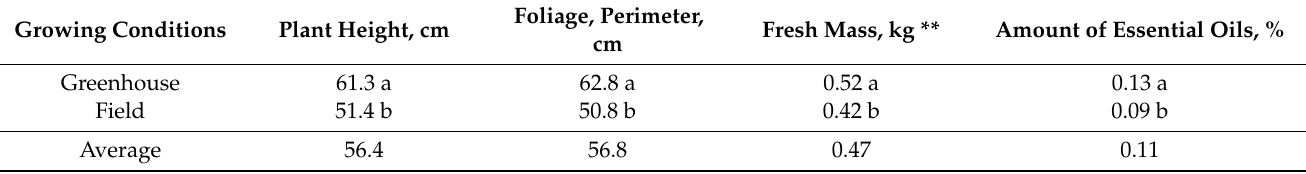
Table 6. The influence of growing conditions on the morphological futures, productivity, and amount of essential oil of basils